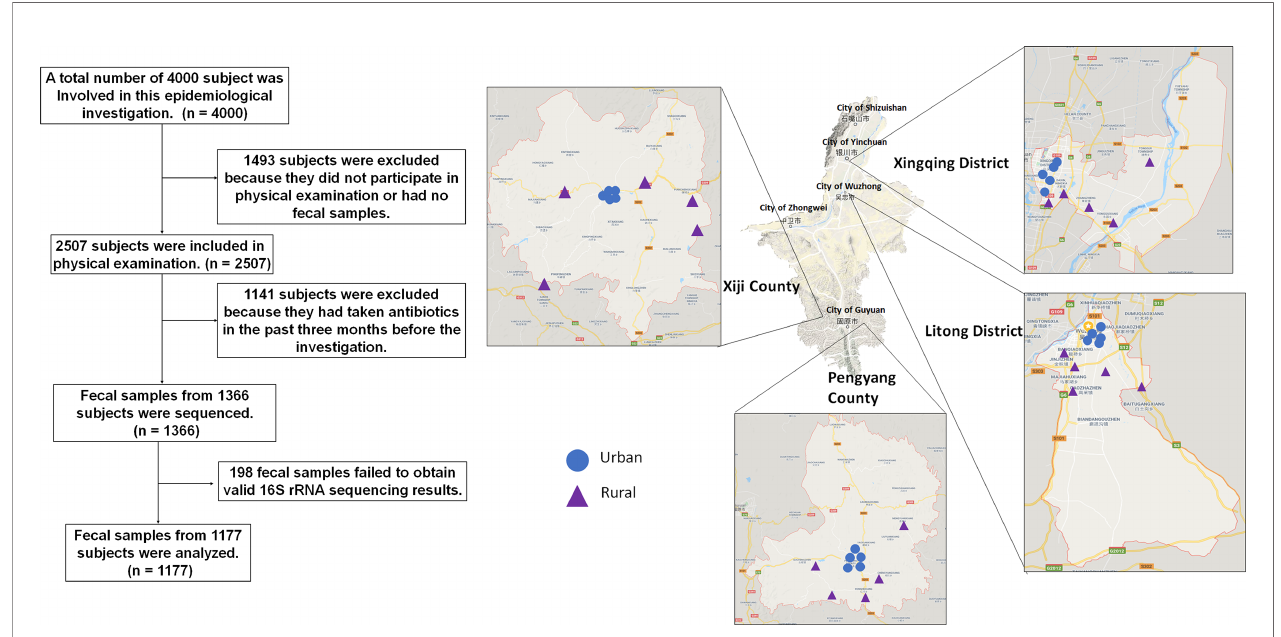
FIGURE 1 | Screening Process and fl ow